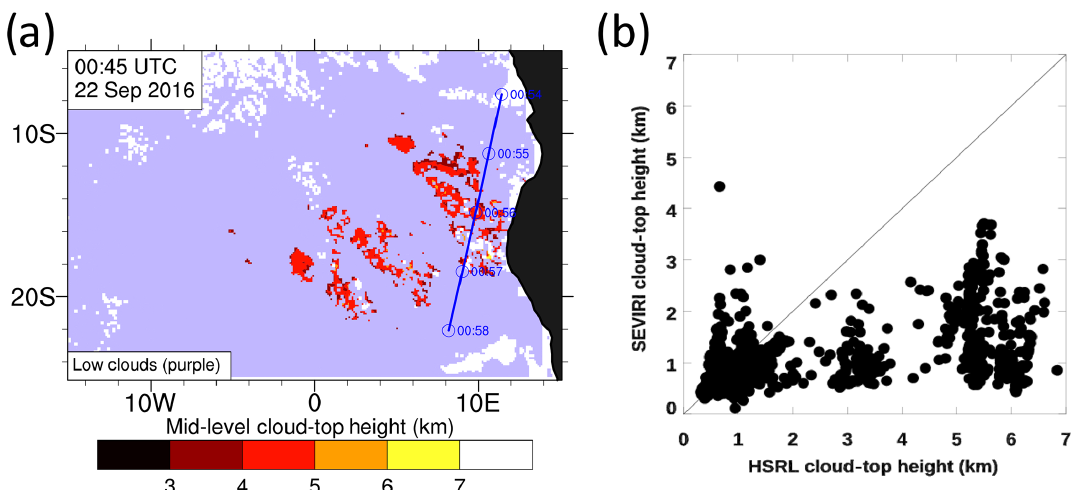
Figure 3. Comparison between mid-level clouds observed by SEVIRI and lidar-based instruments. (a) Image from the SEVIRI instrument corresponding to the CALIPSO image in Fig. 2a. This was taken at 00:45UTC on 22 September 2016, and it shows the mid-level cloud-top heights (km; red-yellow shade) and the low-level clouds (purple; defined by cloud-top heights less than 3km) over the southeast Atlantic. The blue line is the CALIPSO crossover track for the image in Fig. 2a, although it occurs 9min after the satellite image. (b) Comparison between SEVIRI and HSRL-2 cloud-top height collocated within ± 15min of each other during